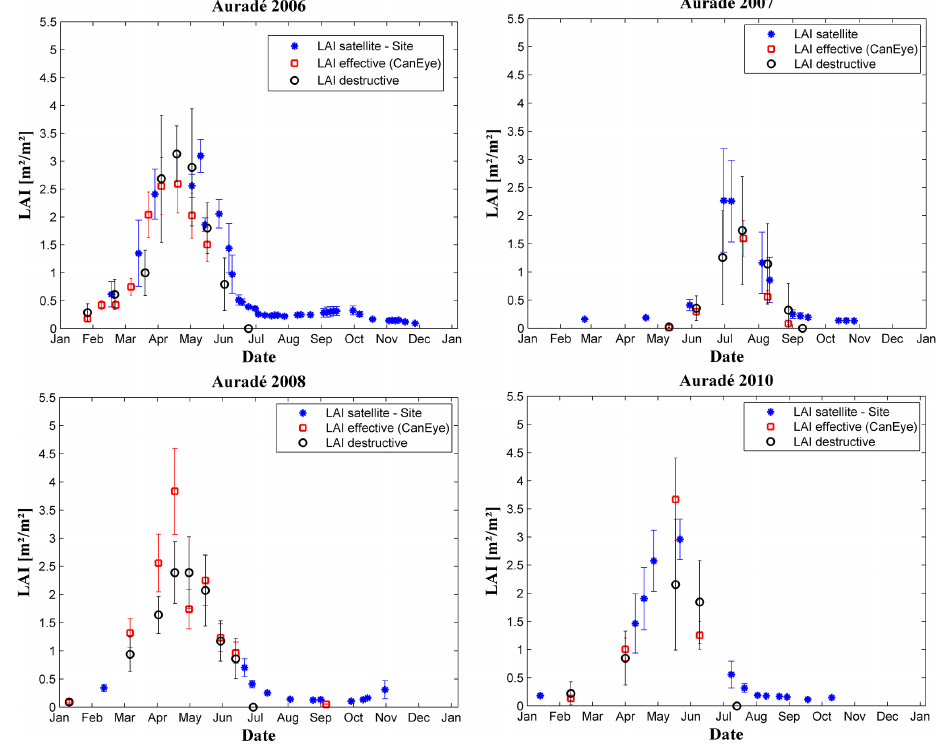
Figure 4. Leaf area index derived from satellite F2 images, hemispherical photographs (LAI effective CanEye), and direct field measurement (LAI destructive) in the experimental crop field located near the Auradé catchment (see location in Fig. 1). The standard deviation represents the spatial variability within the crop field (LAI satellite), spatial variability and associated sampling error (LAI destructive), and uncertainty concerning the photo interpretation (LAI